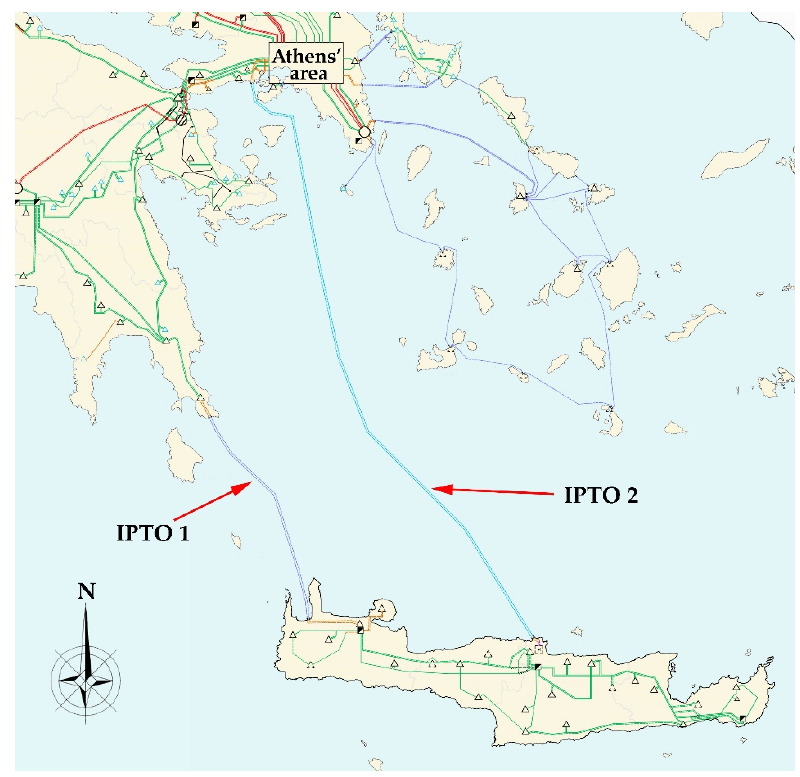
Figure 11. The two routes (IPTO 1 and IPTO 2) of the national electrical interconnection of Crete with the mainland grid of Greece [67].